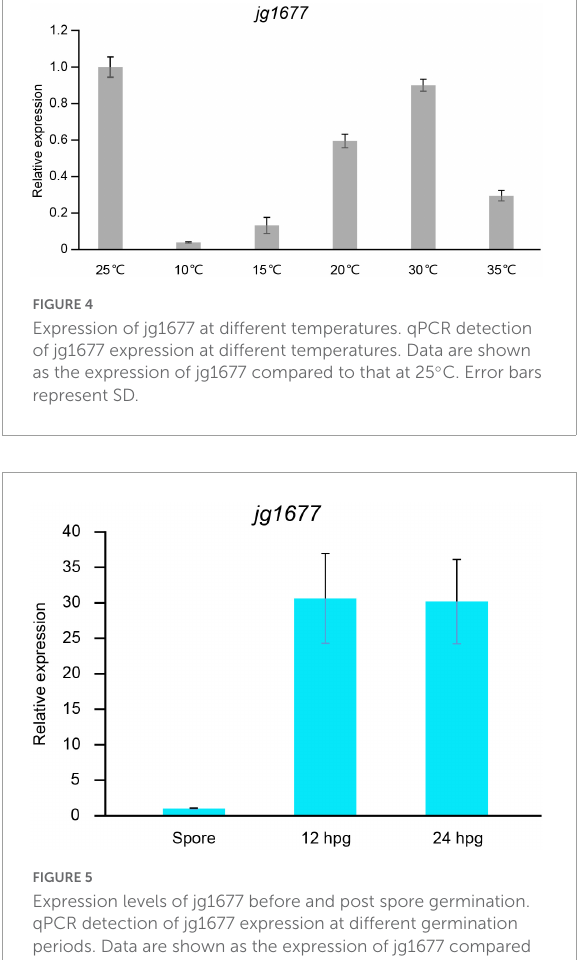
FIGURE5 Expression levels of jg1677 before and post spore germination. qPCR detection of jg1677 expression at different germination periods. Data are shown as the expression of jg1677 compared to conidia. Error bars represent SD.